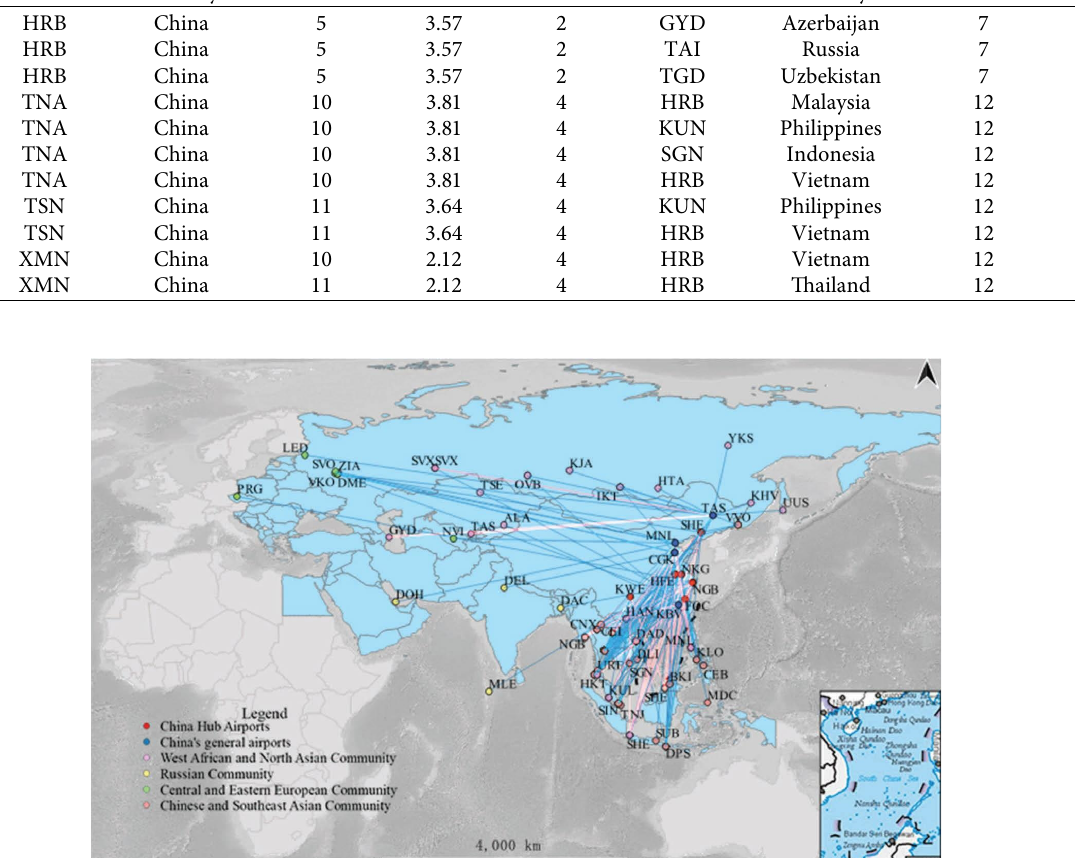
Figure 13: Scheme diagram of Chinese airports deeply integrated into the communities where they